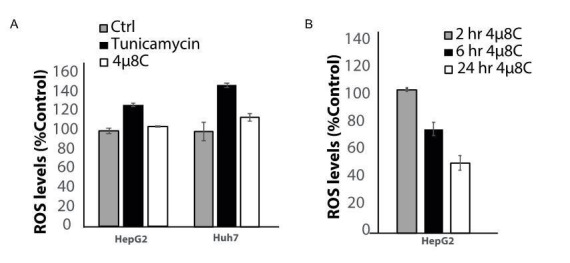
Effect of ER-stress on ROS production.(A) the ER-stress inducer increases ROS levels in HepG2 and Huh7 cells. (B) The ROS-scavenging effect of 4u8C increases over time.